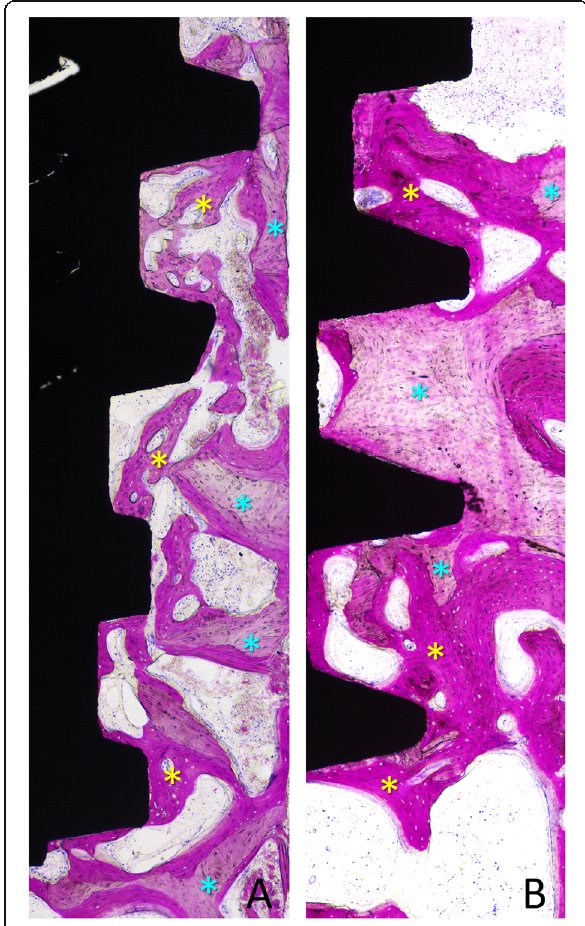
Fig. 5 a , b Photomicrographs of ground sections of devices installed with old bone (light blue stars). Images originally grabbed at × 100 magnification. Acid fuchsine and toluidine blue stain